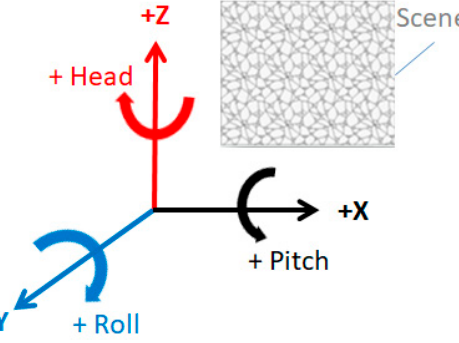
Figure 13. Cartesian coordination system of scene.